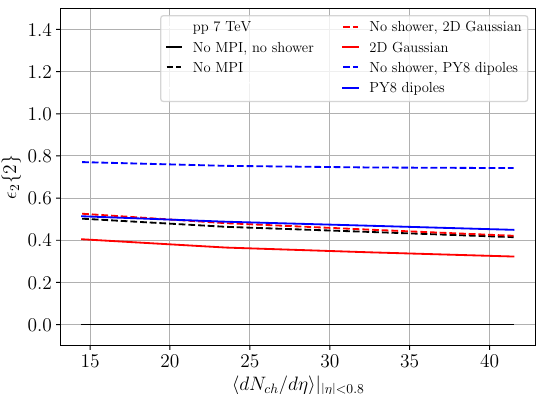
Figure 11. The eccentricities in pp collisions obtained with the several di(cid:11)erent options: No MPI vertex assignment and no shower smearing (solid black lines), no MPI vertex assignment, with shower smearing (dashed black lines), the 2D Gaussian MPI vertex with/without shower smearing (solid/dashed red lines, respectively) and the dipole model MPI vertex assignment with/without shower smearing (solid/dashed blue